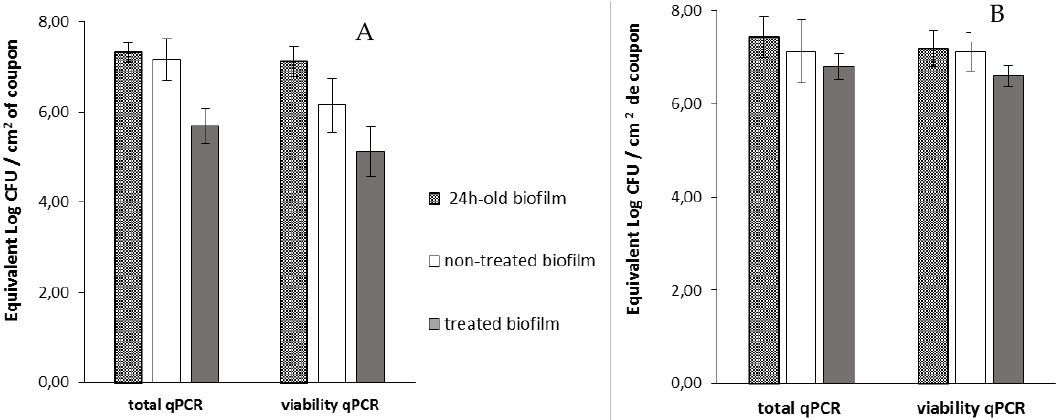
Figure 6. The effect of the bacteriophage LUZ7 on 24 h old biofilms of P. aeruginosa ( A ) on the PAO1 reference strain and ( B ) on D1 isolates from the thermal environment. The data represent the average of three biological replicates and the standard deviations are indicated by vertical bars.